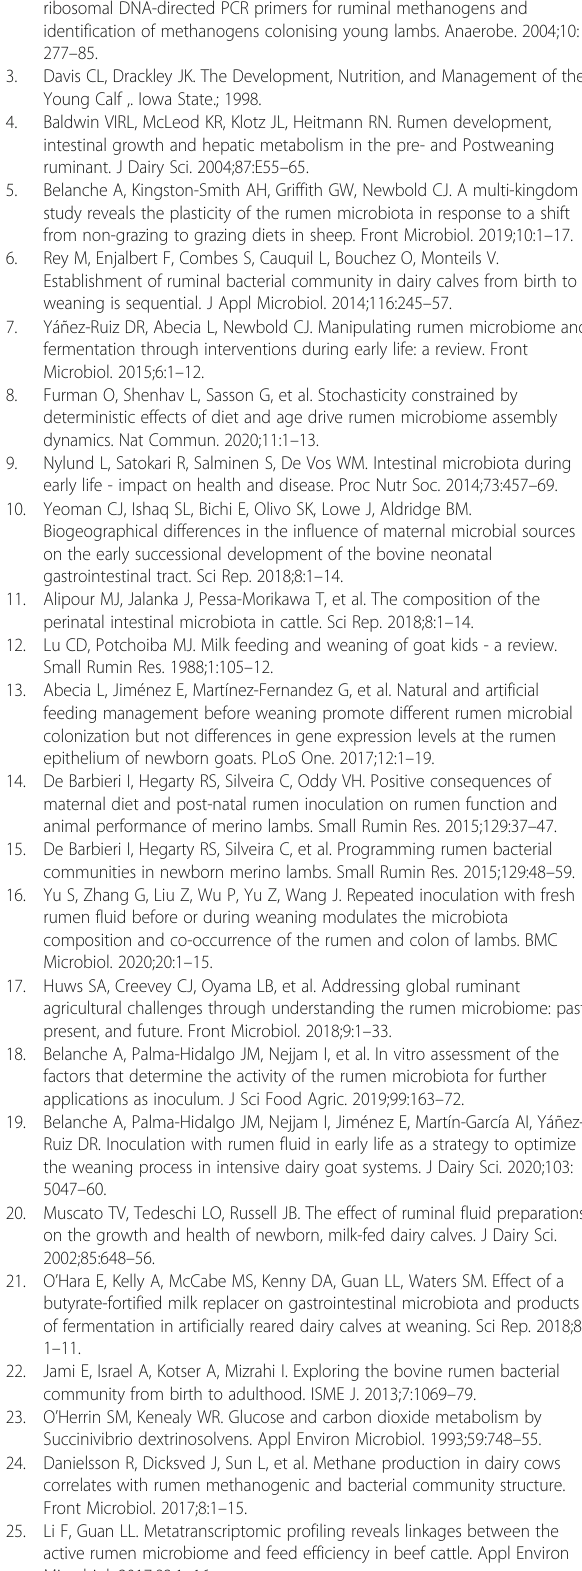
Table S5. Effect of early-in-life rumen microbial inoculation and age on the rumen protozoal concentration, diversity and taxonomy. Table S6. Effect of early-in-life rumen microbial inoculation and age on the rumen anaerobic fungal concentration, diversity and taxonomy. Table S7. De- scriptive statistics of the metadata used in the distance-based redun- dancy analyses and spearman correlations with microbial taxa abundance. Table S8. Primers used for quantitative PCR and Next Gener- ation Sequencing. Fig. S1 . Principal co-ordinates analysis illustrating the inoculation effects on the multi-kingdom rumen